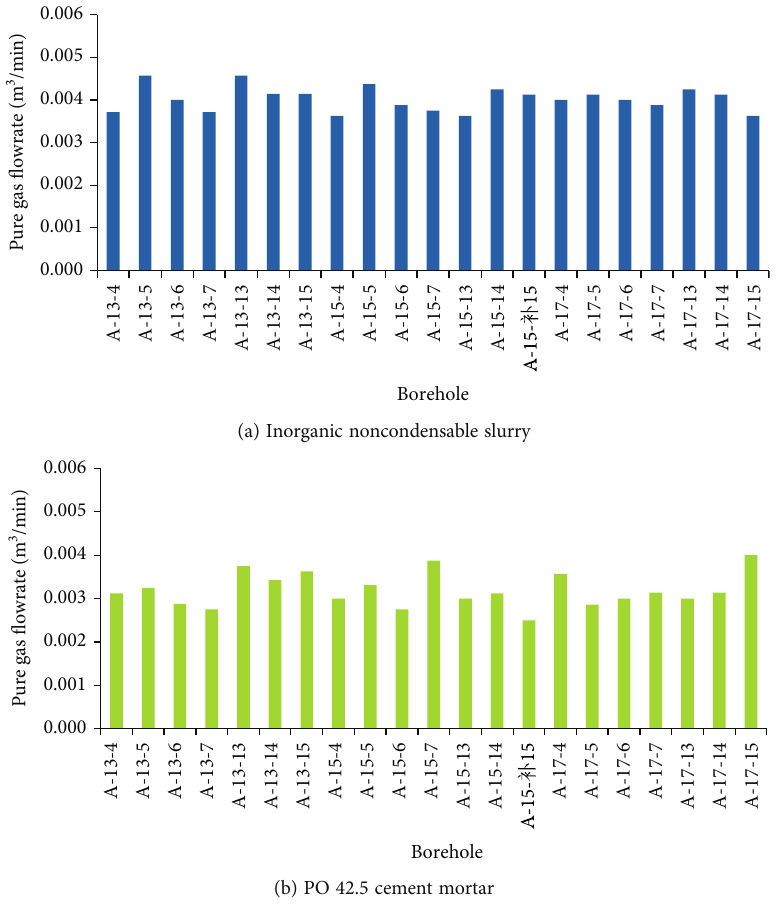
Figure 15: Average pure gas fl ow rate in the two group